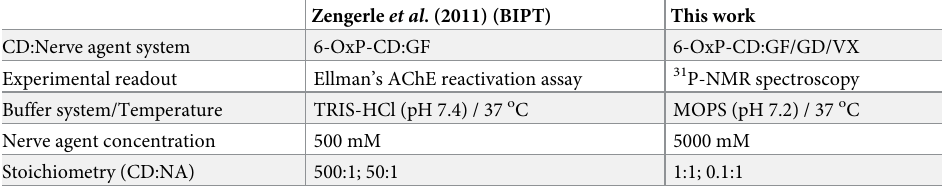
Table 1. Comparison of the evaluation methods for determining 6-OxP-CD’s ability to degrade GF at the Bundes- wehr Institute for Pharmacology and Toxicology (BIPT) and the Forensic Science Center (FSC) at LLNL. While studies at BIPT focused on GF only, our studies have expanded the evaluation of 6-OxP-CD to include GD and